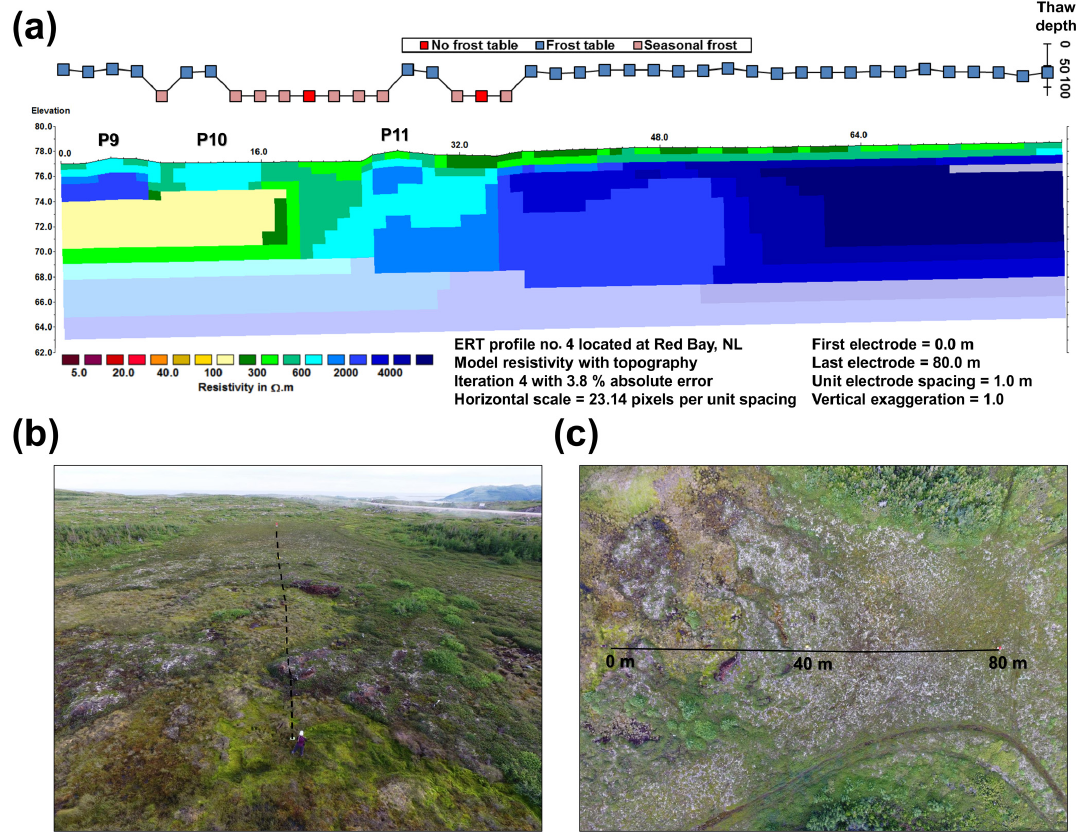
Figure 5. Peatland permafrost at Red Bay. (a) Frost tables and modelled resistivities on ERT profile 4. (b) Oblique aerial photo upslope along ERT profile 4 from the survey start point. Dotted black line delimits location of ERT survey line. (c) UAV vertical image of the site. Black line delimits the approximate location of the ERT survey line and text shows the start and end